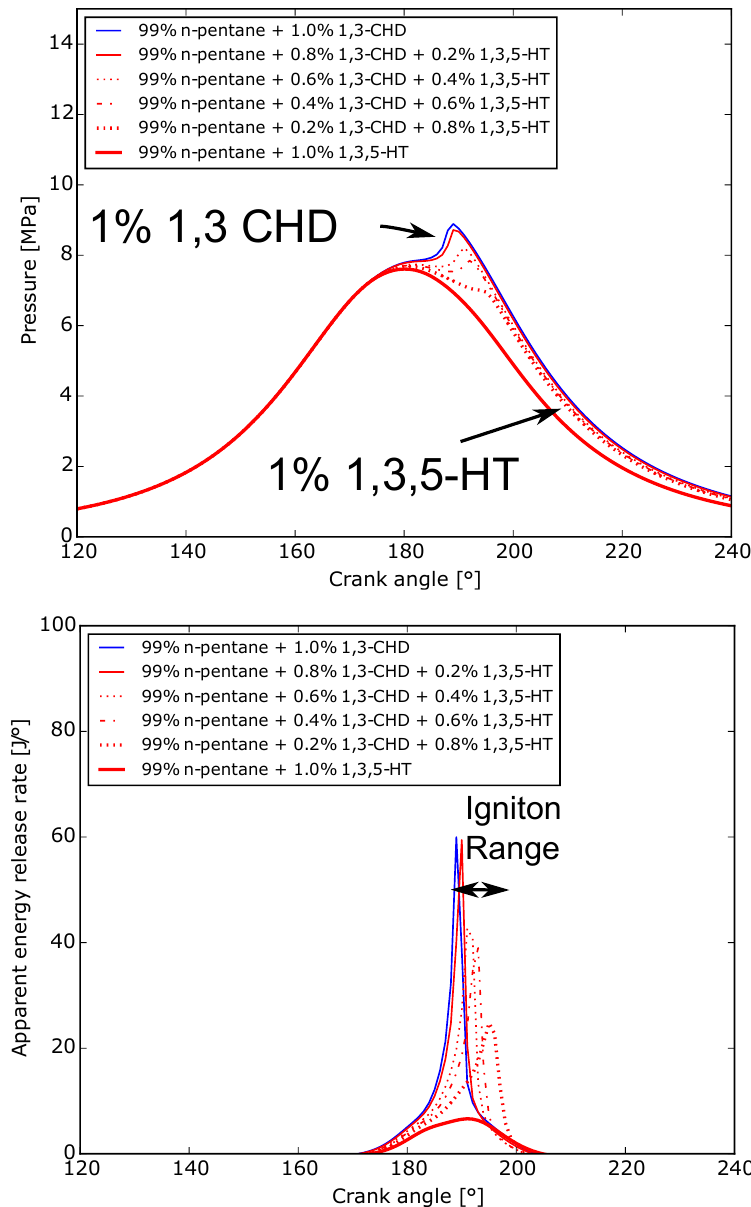
Figure 2. Chemical kinetic engine simulation of a 1% 1,3-cyclohexadiene (1,3-CHD) in 99% n-pentane converted in various fractions to 1,3,5-hexatriene (1,3,5-HT). The cylinder pressure ( upper graph ) and apparent heat release rate ( lower graph ) show that a concentration of 1% is effective in controlling ignition photo-chemically in the